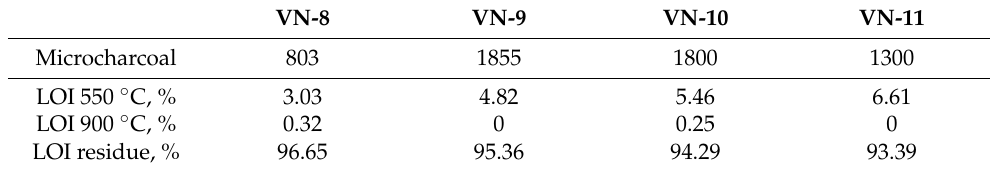
Table 2. Results of the LOI and microcharcoal analyses at the Voorthuizen archaeological site. VN-8 VN-9 VN-10 VN-11 Microcharcoal